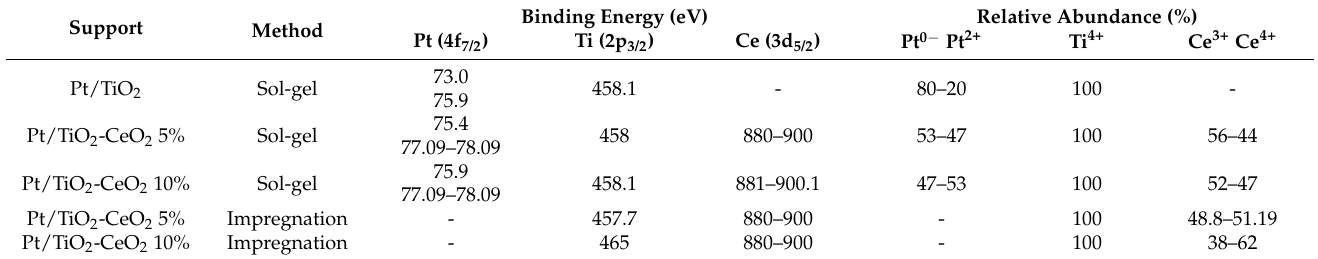
Table 2. Binding energy and relative abundance of the different species obtained by XPS of the catalysts.